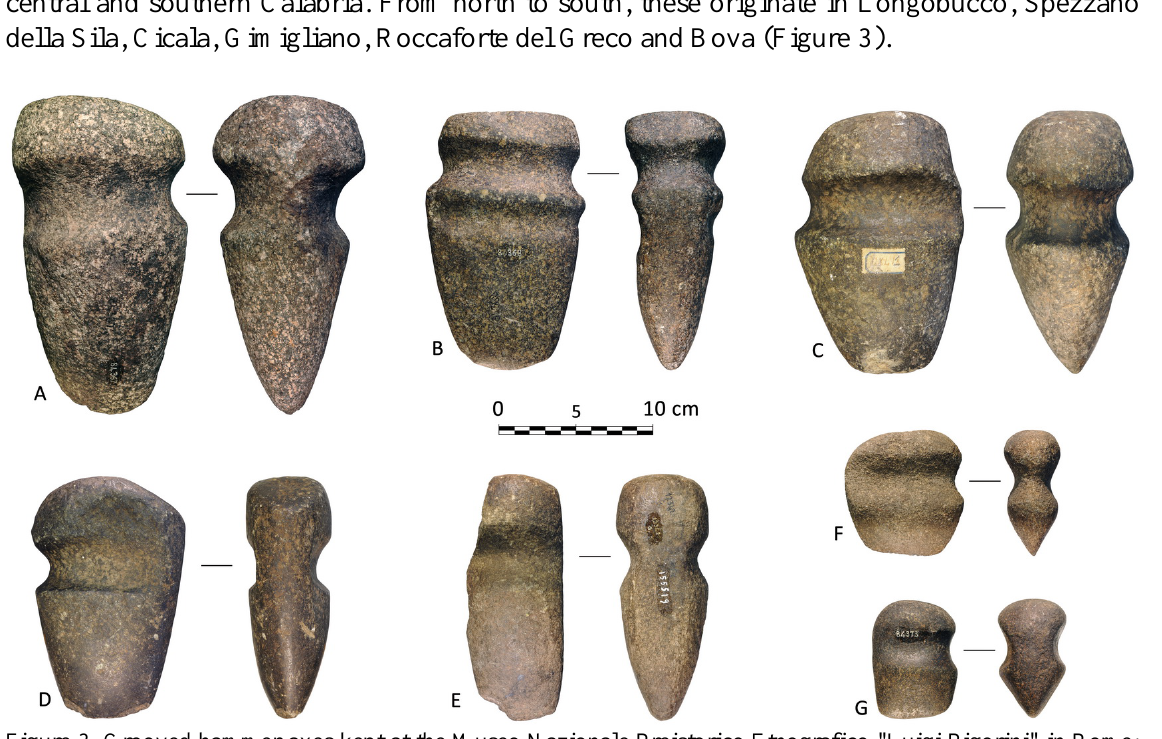
Figure 3. Grooved hammer-axes kept at the Museo Nazionale Preistorico Etnografico "Luigi Pigorini" in Rome: A-B. From Cicala (Catanzaro), ID 84367 / ID 84368; C-D. From Roccaforte del Greco (Reggio Calabria), ID 84364 / ID 84365; E-F. From Longobucco (Cosenza) , ID 12342 G / ID 13007 G; G. From Cicala (Catanzaro), ID